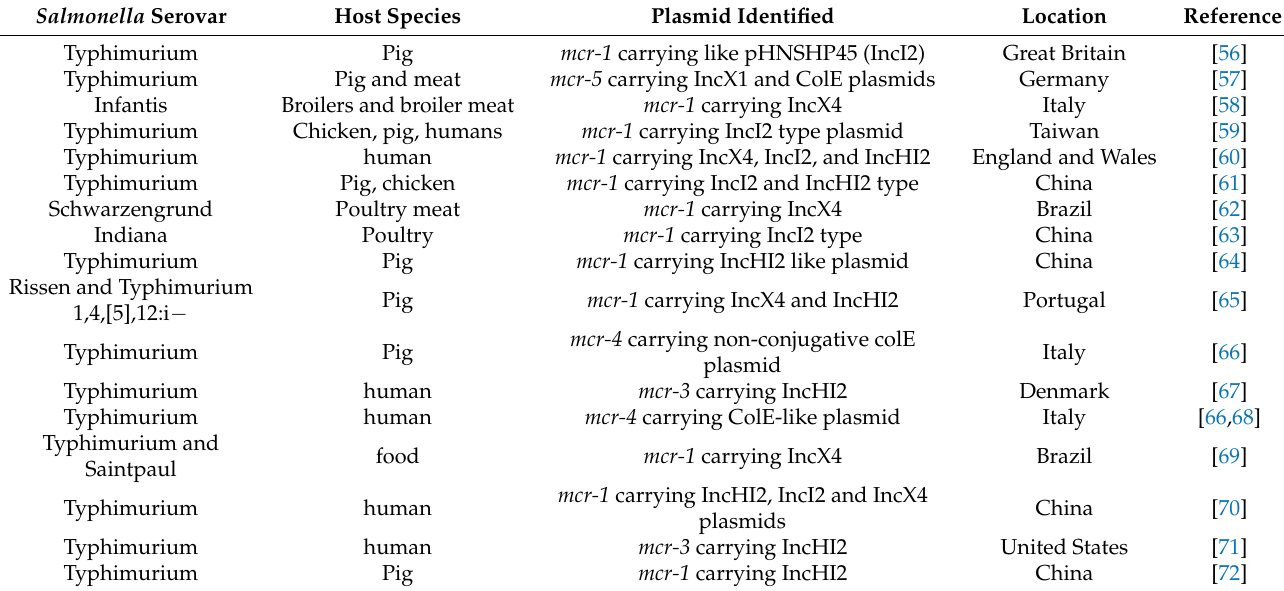
Table 2. Salmonella serovars carrying plasmid-mediated mcr genes from food animals and